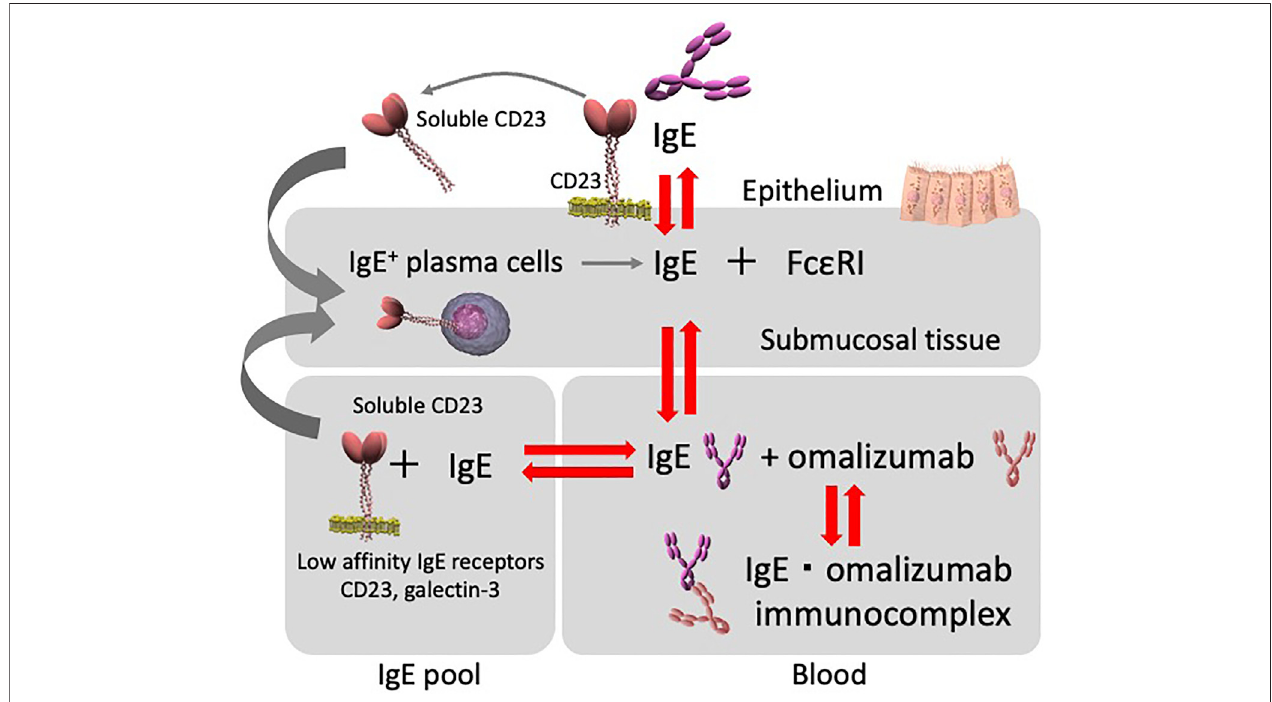
FIGURE3| DiagramdepictingtherelationshipbetweenserumandtissueIgE,andomalizumab.IgEinteractions.SerumIgEconcentrationsandthetissueIgEpool with cells expressing low-af fi nity IgE receptors (e.g., CD23/Fc ε RII) are all interconnected and regulate serum free IgE levels. Furthermore, CD23/Fc ε RII is involved in the inhibition of IgE production. Total serum free IgE levels during omalizumab therapy appear to be affected by each compartment.